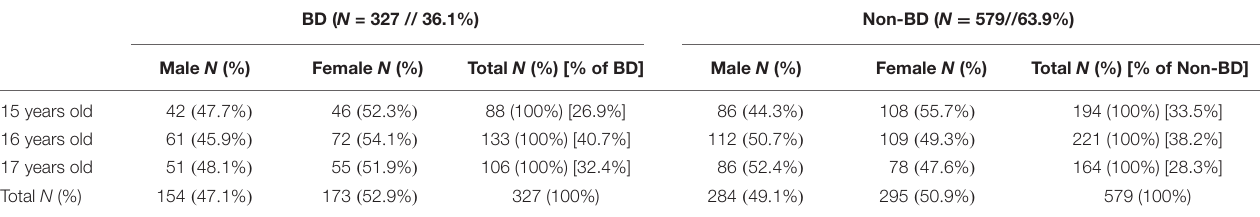
TABLE 1 | Demographic characteristics of